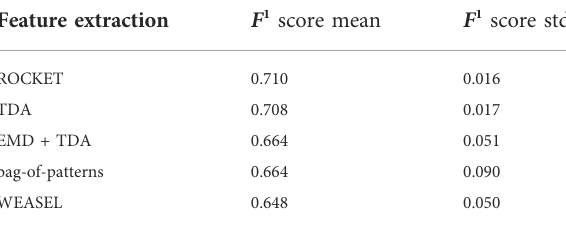
TABLE 2 Comparison between TDA and four other methods and their effect on performance.